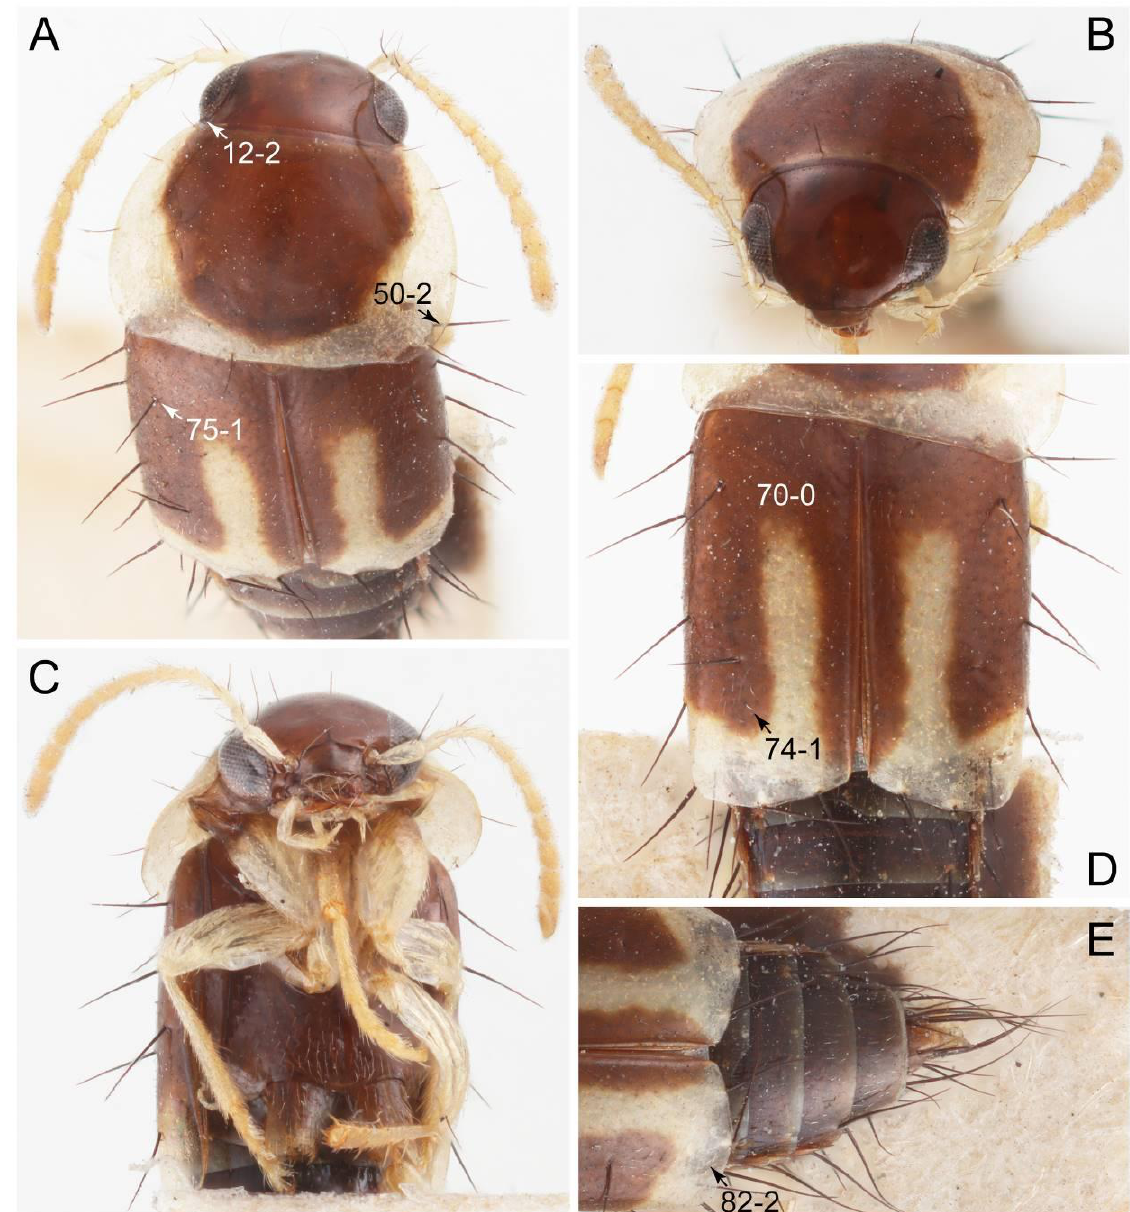
Figure 8. Photographs of body parts of Tachyporini: Tachyporina, enlarged ( Symmixus sikkimensis , holotype). ( A ) forebody, dorsal view. ( B ) head and pronotum, frontal view. ( C ) forebody, ventral view. ( D ) elytra, dorsal view. ( E ) apical half of elytra and abdomen, dorsal view. Characters and character states (format X-X) are indicated on the selected